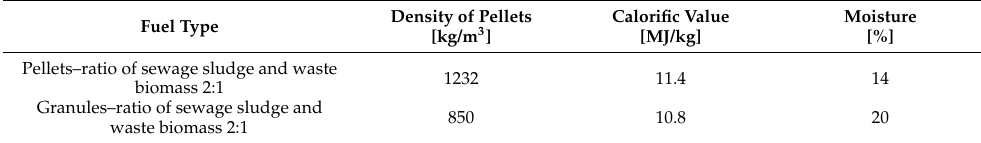
Table 3. Fuel main